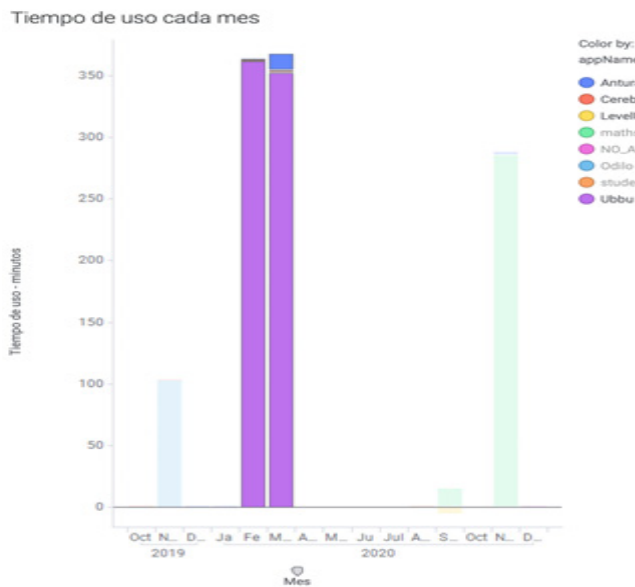
Figure 8. Digital resources usage time per month.